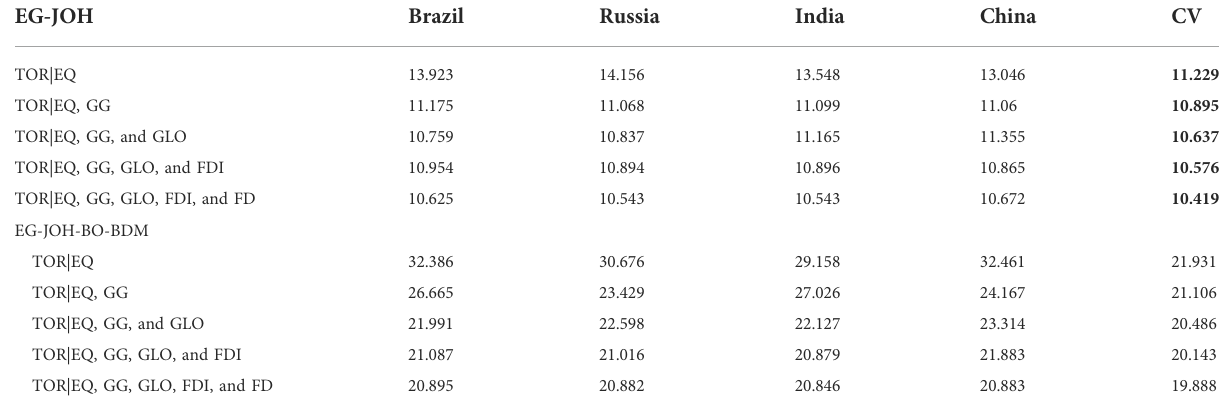
TABLE 4 Results of combined cointegration